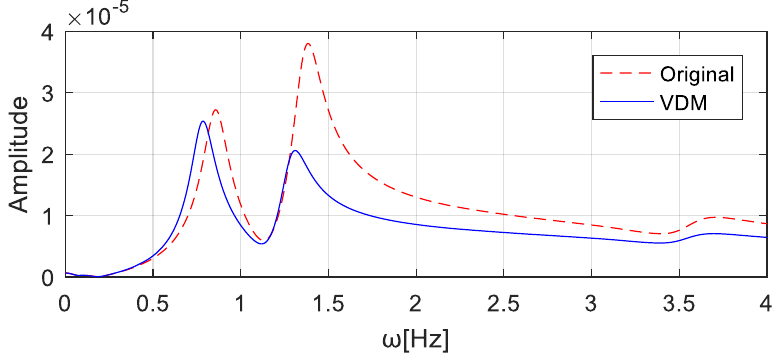
Figure 26. Acceleration frequency responses at T 2 wheel position with the virtual mass added to the wheel T 2 .